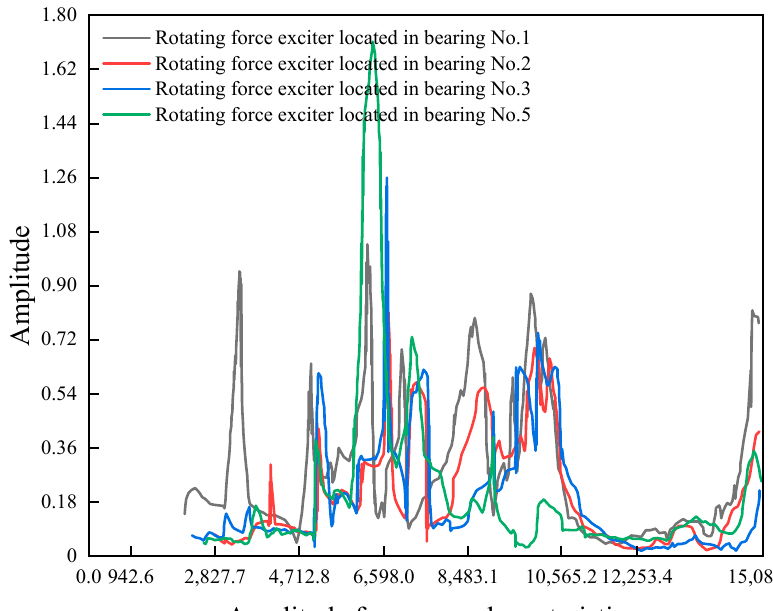
Figure 8. Vibrational transmission ratio amplitude characteristics for radial measuring point of bear- ing 1 with exciting force acted at different locations.